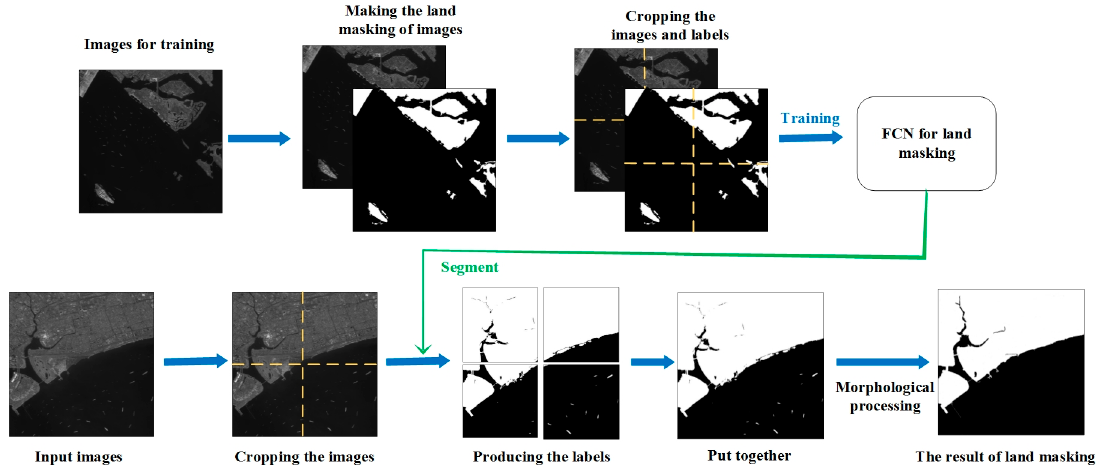
Figure 1. The process of land masking based on the fully convolutional network (FCN).